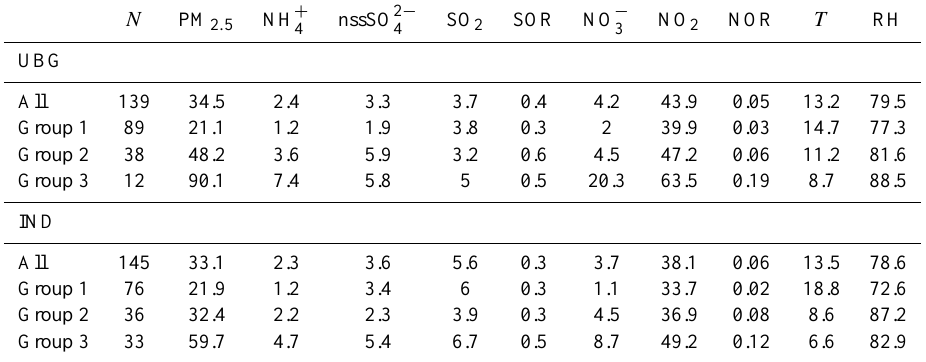
Table 5. Average values for each group identified by qHCA analysis. SRC data have not been considered in this analysis because the concentrations of SO 2 and NO 2 are not available for this